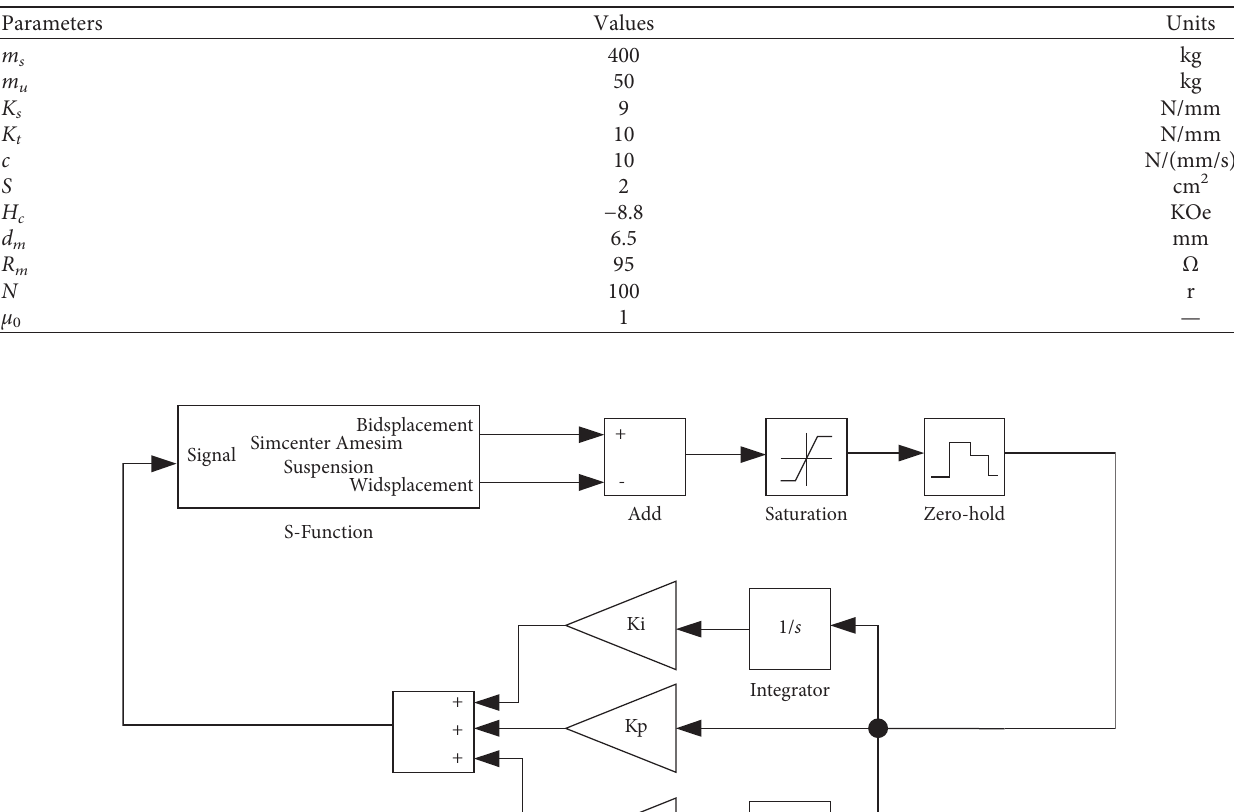
Table 3: Main simulation parameters.